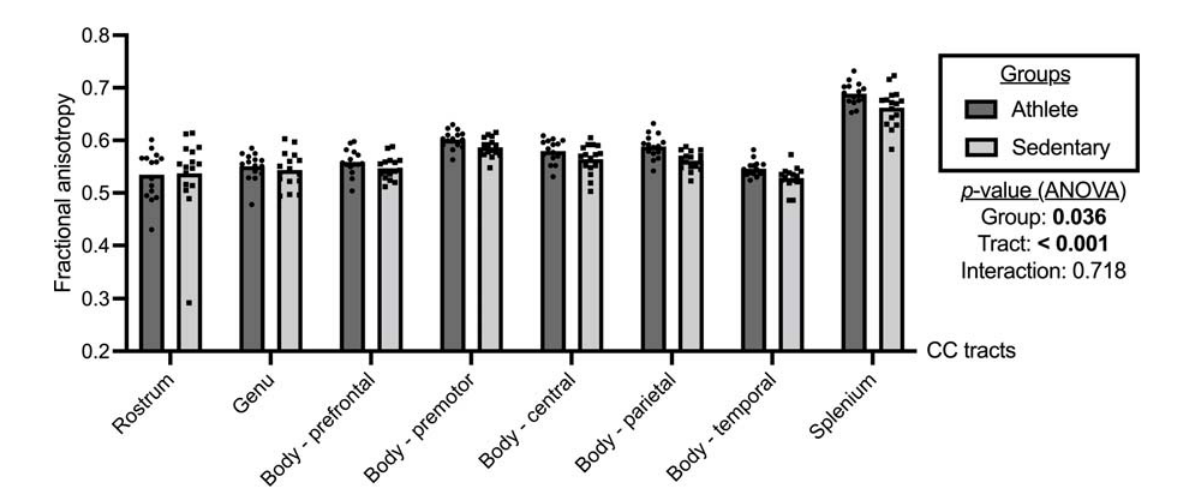
FIGURE2 Fractional anisotropy of the corpus callosum (CC) tracts compared between the athlete and sedentary groups. Two-way mixed analysis of variance (ANOVA) examined the main effects of group and CC tract and their interaction